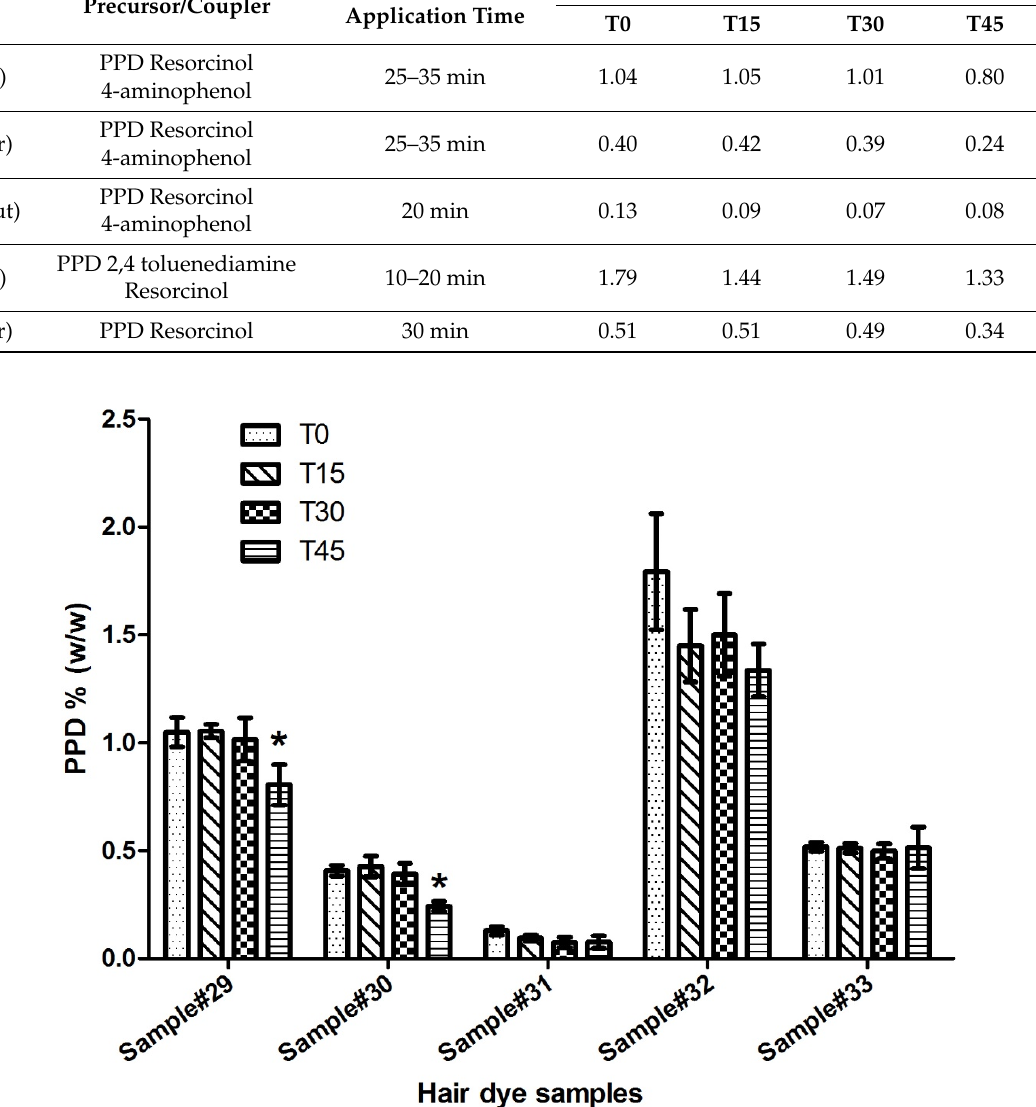
Figure 2. Comparison of unreacted PPD in hair dye samples after different incubation times. Results are expressed as mean ± S.D. of three measurements. * p < 0.05 compared to T0.